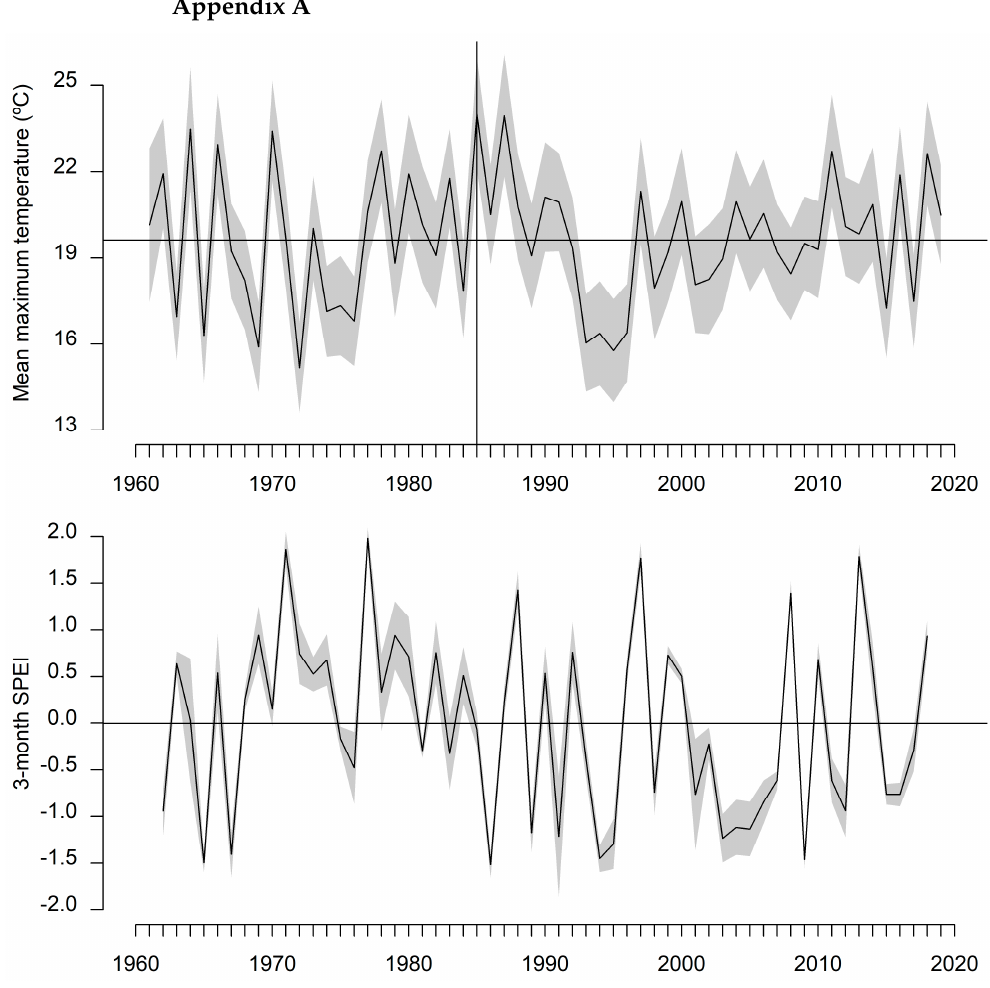
Figure A1. Mean maximum temperature and 3-month July SPEI in the 1963–2016 period in the studied silver fir stands. The black solid line indicates the average value, and the shaded area the 95% confidence interval. The vertical line in the upper plot indicates the 1985 warm year.